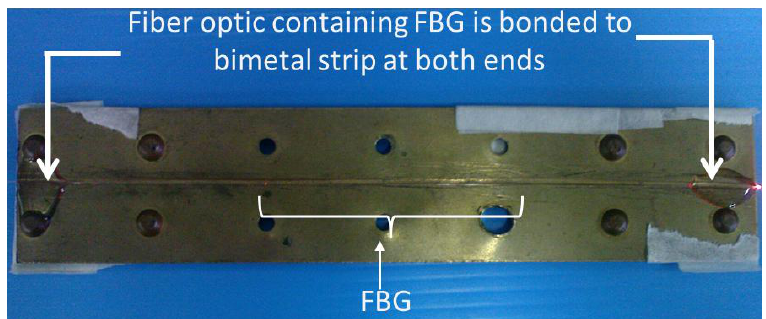
Figure 1. FBG-Bimetal temperature sensor